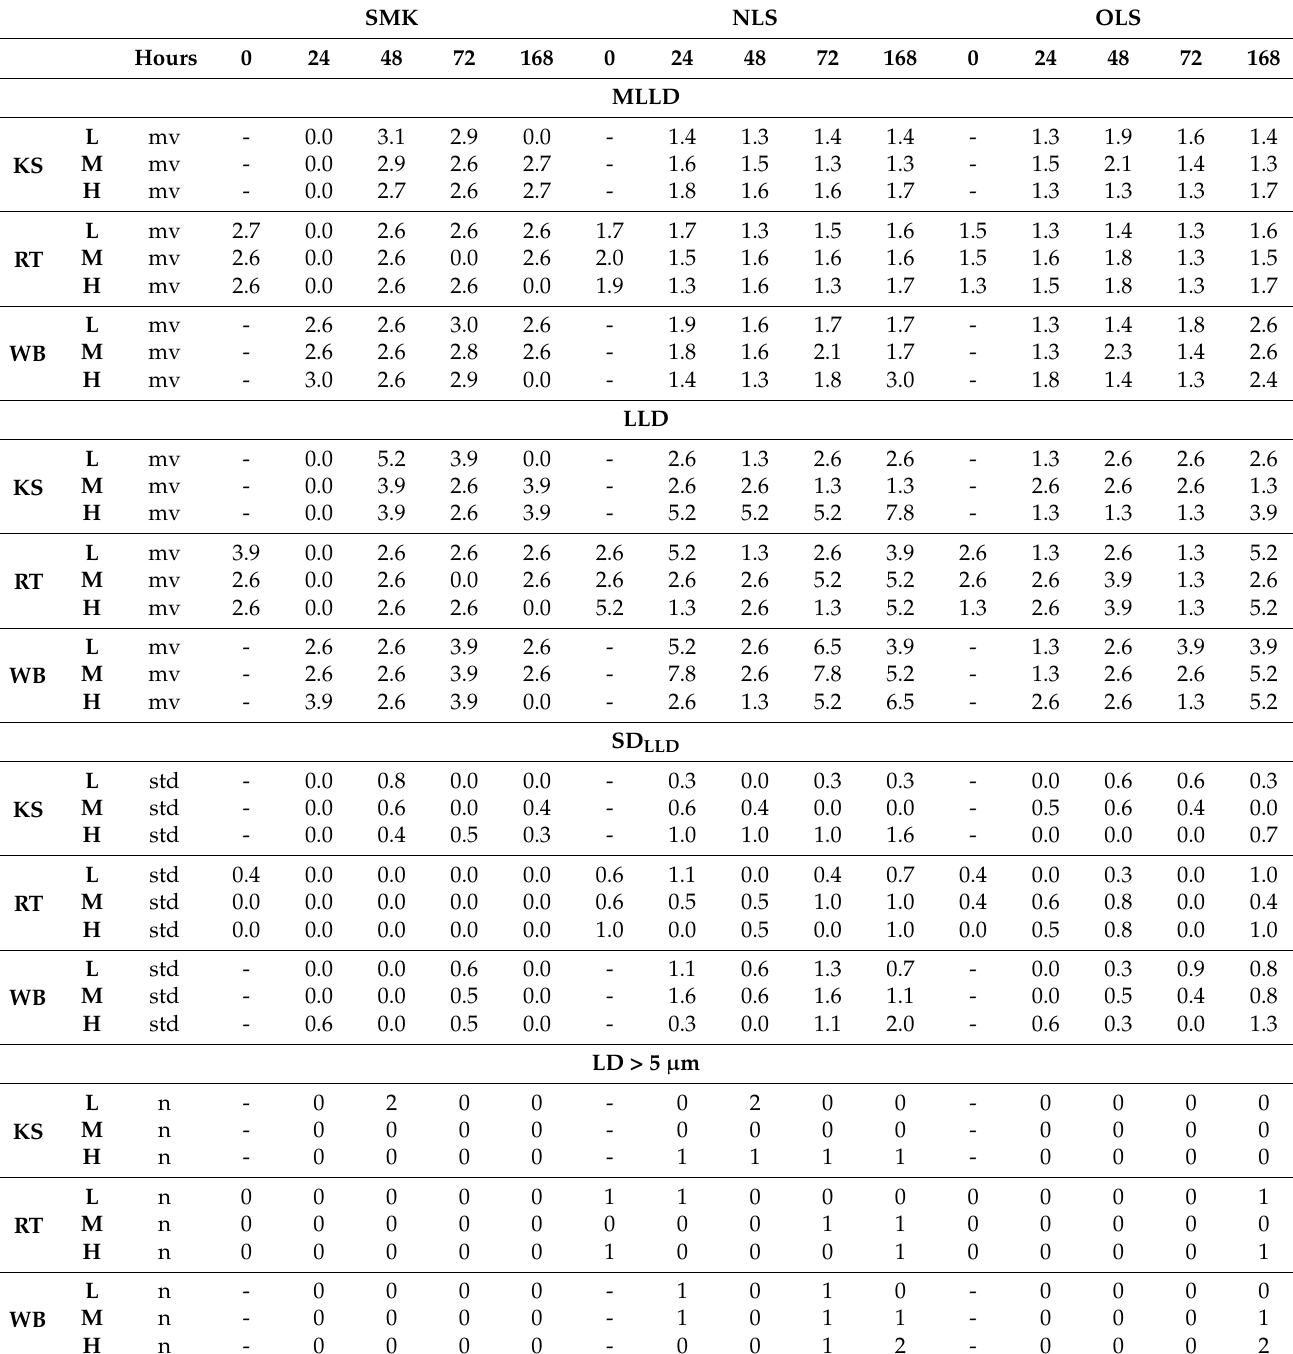
Table 4. Results of the visual microscopic analysis (size in µ m and counts).